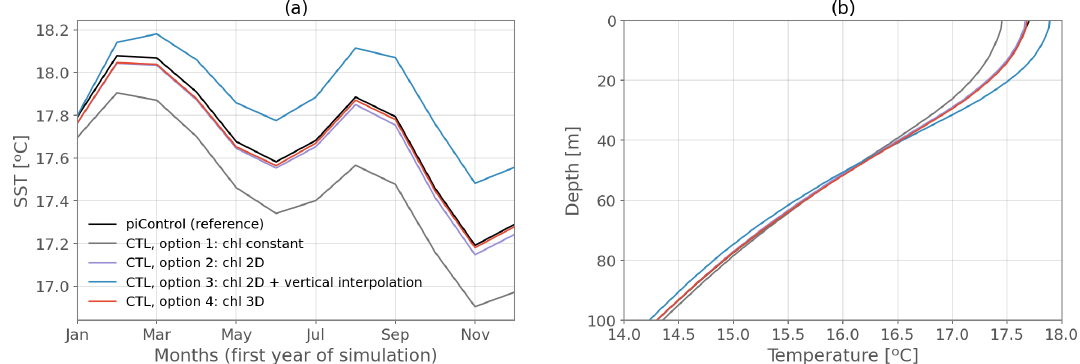
Figure 4. (a) Monthly globally averaged SST the first year of the simulation and (b) annual-mean globally averaged temperature profile in the first 100m, for the coupled piControl (black), CTL with the 3D chlorophyll read from the piControl (red), CTL with the 2D chlorophyll read from the piControl and interpolated vertically (blue), CTL with the 2D chlorophyll read from the piControl and the same values imposed in the subsurface (purple), and CTL with a constant and uniform chlorophyll value